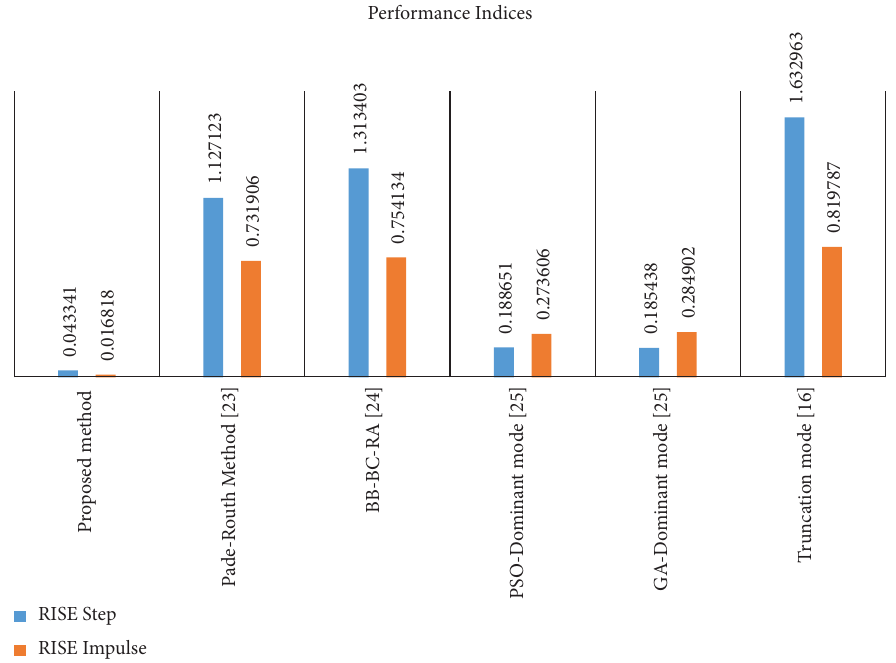
Figure 7: Graphical representation of performance indices obtained by proposed method and other methods.